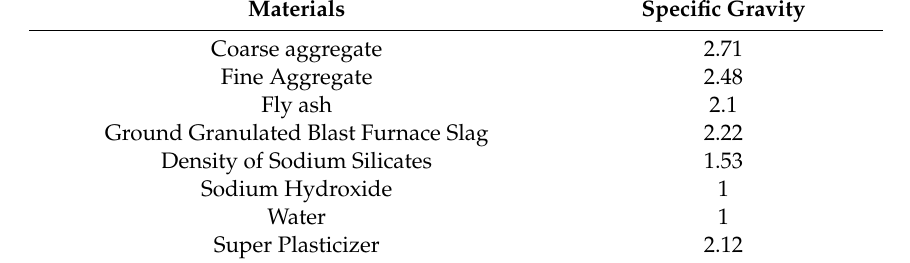
Table 3. Specific gravity and density of di ff erent materials.